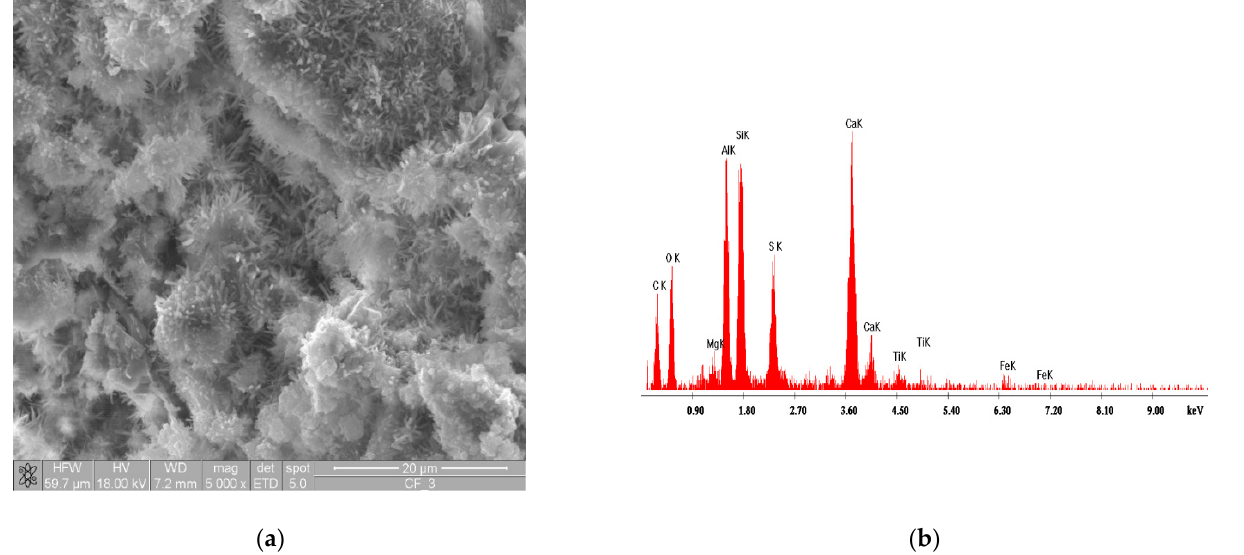
Figure 6. ( a ) Microstructure of the hardened water suspension of FBC fly ash from burning lignite (SEM); ( b ) analysis of average microareas (EDS).